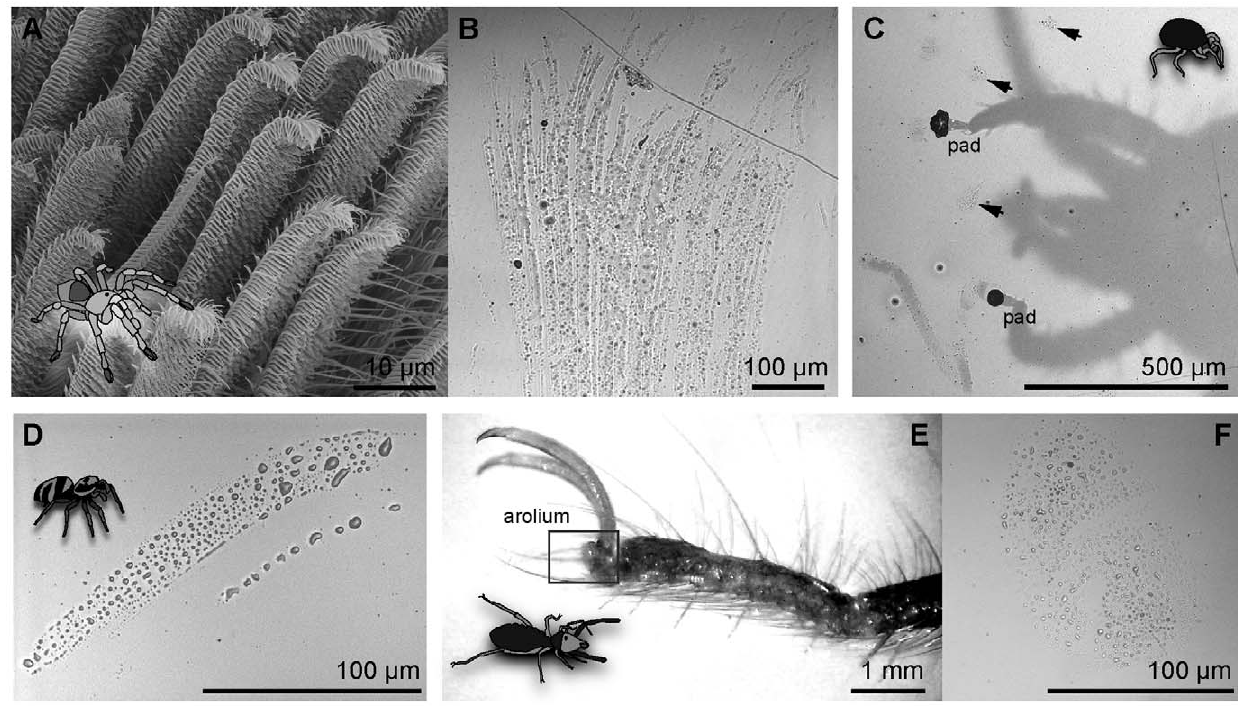
Figure 1. Arachnids investigated for this study. (A) Tarantula ( Grammostola rosea ) setae. (B) Fluid trail left behind by a Grammostola tarsus. (C) Mite ( Gromphadorholaelaps schaeferi ) clinging upside down to a polystyrene-coated glass coverslip, showing two adhesive pads in contact. Footprints are indicated by arrowheads. A trail of fluid is also visible, lower left. (D) Jumping spider ( Salticus scenicus ) fluid trail from one tarsus. (E) Solifugid ( Gluvia dorsalis ) tarsus, arolium situated distally, at base of claws. (F) Fluid footprint left by one Gluvia arolium.